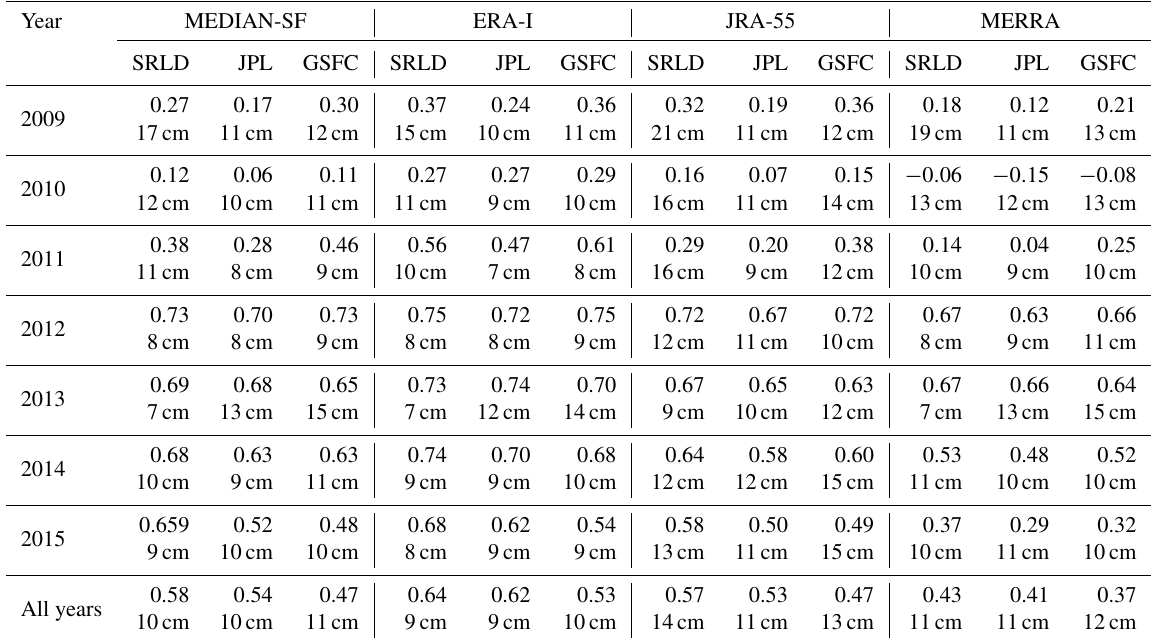
Figure 15. Scatter plots of the three OIB snow depth products binned onto our 100km model grid and coincident NESOSIM/MEDIAN-SF snow depth estimates for all years of data from 2009 to 2015, including the correlation coefficient ( r ) and RMSE. The contours show the kernel density estimate of the distributions. Table 5. Correlation coefficient ( r , top rows) and root mean squared error (RMSE, bottom rows) from the correlations between the various reanalysis-forced NESOSIM results and OIB-derived snow depths. The MEDIAN-SF scatter plots for all years of data are shown in Fig. 15, with other reanalysis-forced scatter plots given in the